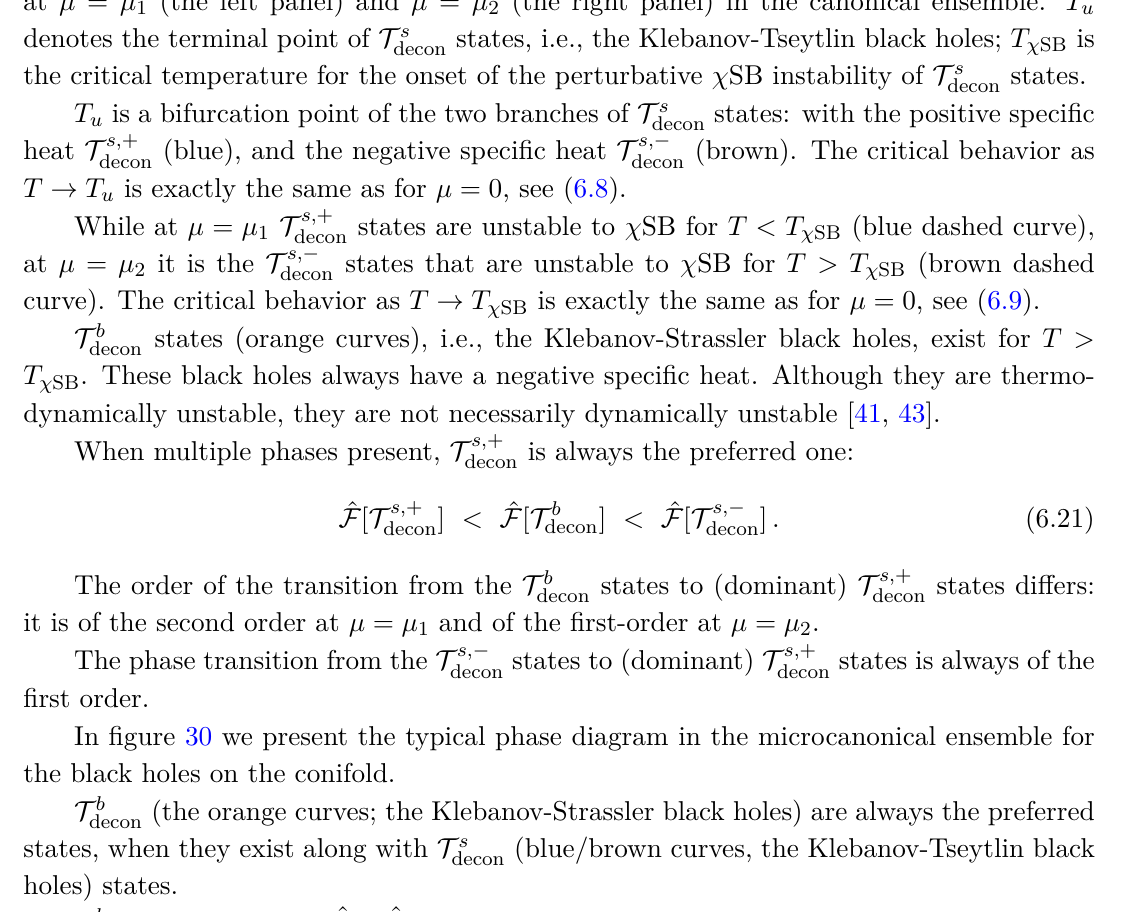
b (the Klebanov-Strassler black holes) for 0 < µ = µ 1 < µ ⋆ decon T